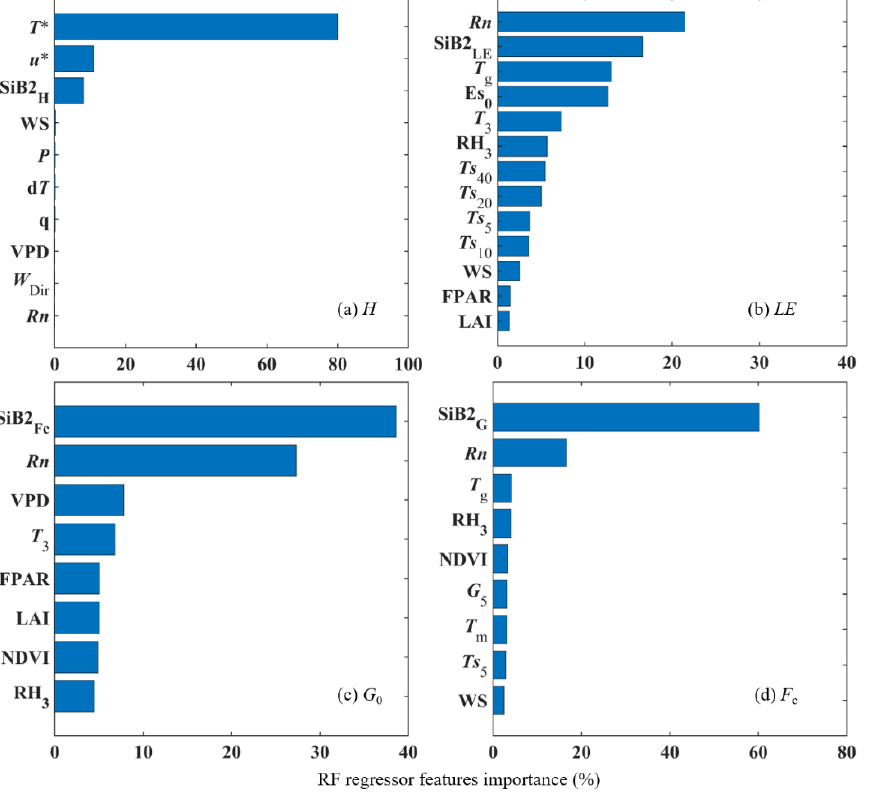
Figure 5. Feature importance for the RF model in Dongtai County.